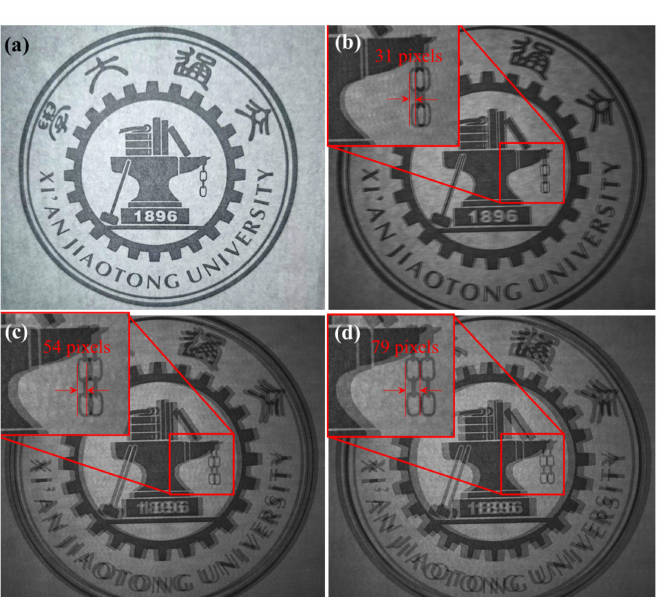
Figure 10. Verification experiment of the beam splitting effect of DWP ( a ) Target; ( b ) Image of s = 0 mm; ( c ) Image of s = 5 mm; ( d ) Image of s = 10